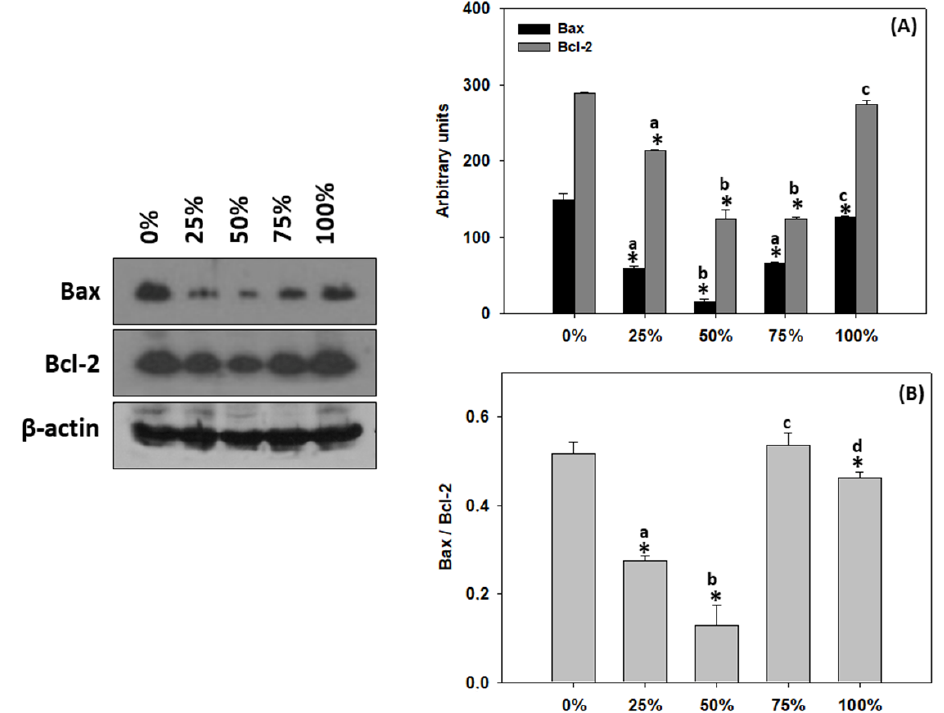
Figure 8. ( A ) Bax, Bcl-2 and ( B ) Bax/Bcl-2 levels (mean ± SD) of Tenebrio molitor larvae reared on substrates containing different content levels of milled carob pods (0, 25, 50, 75 and 100%). Asterisk (*) indicates p < 0.05 compared to 0%, while lower case letters indicate p < 0.05 compared to different carob contents (%).